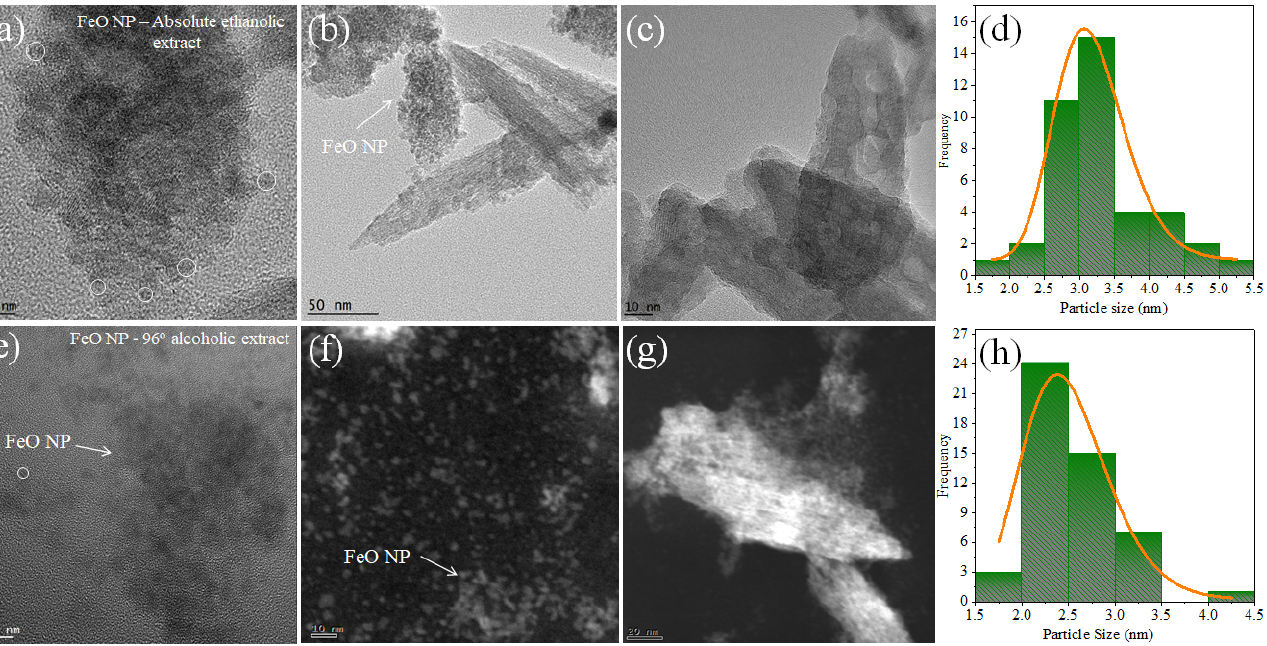
Figure 7. TEM / STEM images and size histogram of FeO NP synthesized using M. indica ( a – d ) with absolute ethanolic extract and ( e – h ) with 96% alcoholic extract.